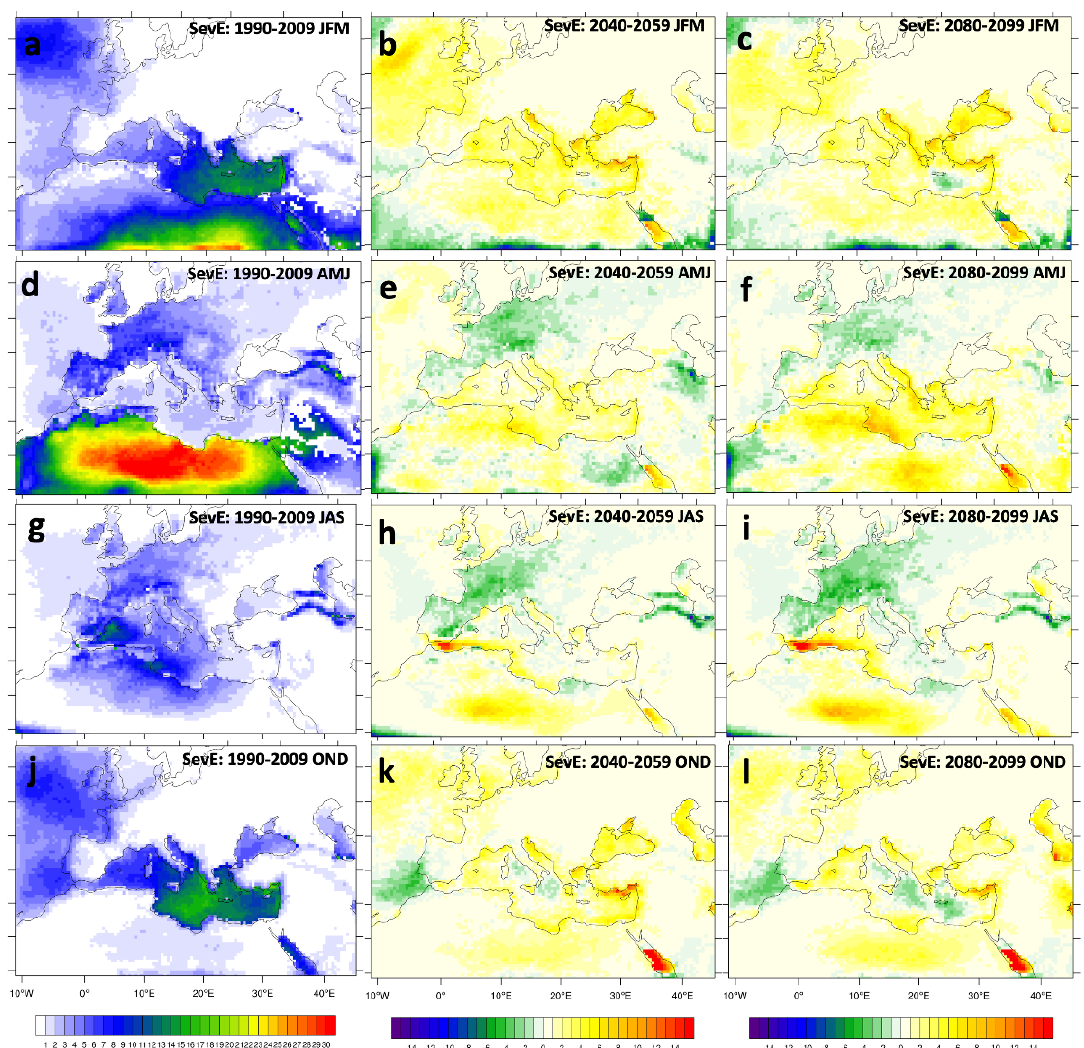
Figure 11. ( a ) Annual average number of days with CAPE ≥ 100 J / kg AND 0–6 km SHEAR ≥ 15 m / s (SevE) for January, February, and March (JFM) of 1990–2009, ( b ) changes in average number of days with SevE for JFM 2040–2059 ,( c ) changes in average number of days with SevE for JFM 2080–2099, ( d ) annual average number of days with SevE for April, May, and June (AMJ) of 1990–2009, ( e ) changes in average number of days with SevE for AMJ 2040–2059, ( f ) changes in average number of days with SevE for AMJ 2080–2099, ( g ) annual average number of days with SevE for July, August, and September (JAS) of 1990–2009, ( h ) changes in average number of days with SevE for JAS 2040–2059, ( i ) changes in average number of days with SevE for JAS 2080–2099, ( j ) annual average number of days with SevE for October, November, and December (OND) of 1990–2009, ( k ) changes in average number of days with SevE for OND 2040–2059, ( l ) changes in average number of days with SevE for OND 2080–2099.